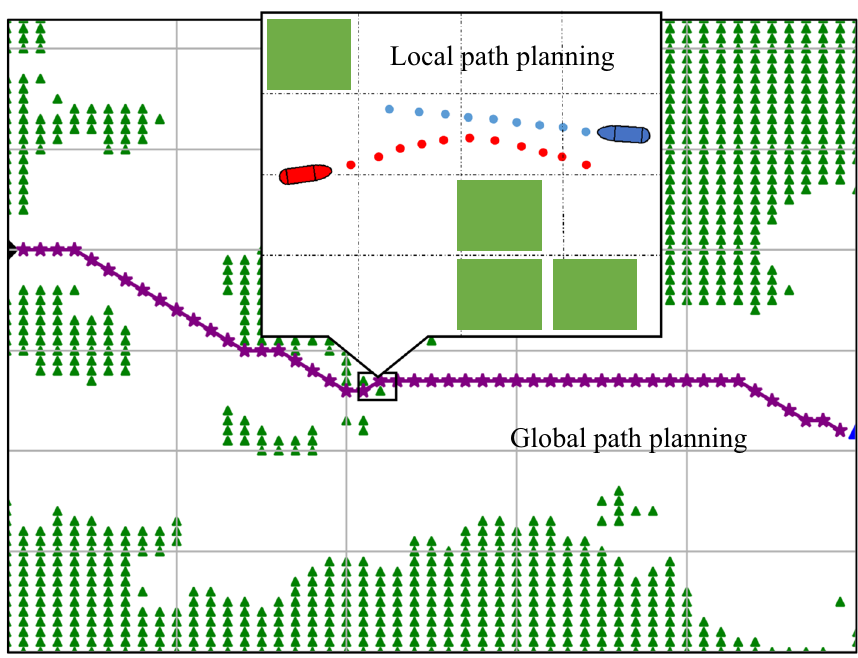
Fig. 1 Schematic diagram of second-order ship path planning. In the local path planning frame, the red ship should try to avoid collision with the blue ship that is sailing straightly. This planning method prioritizes the safety of the planned path and needs to avoid collisions with static obstacles and dynamic ships at the same